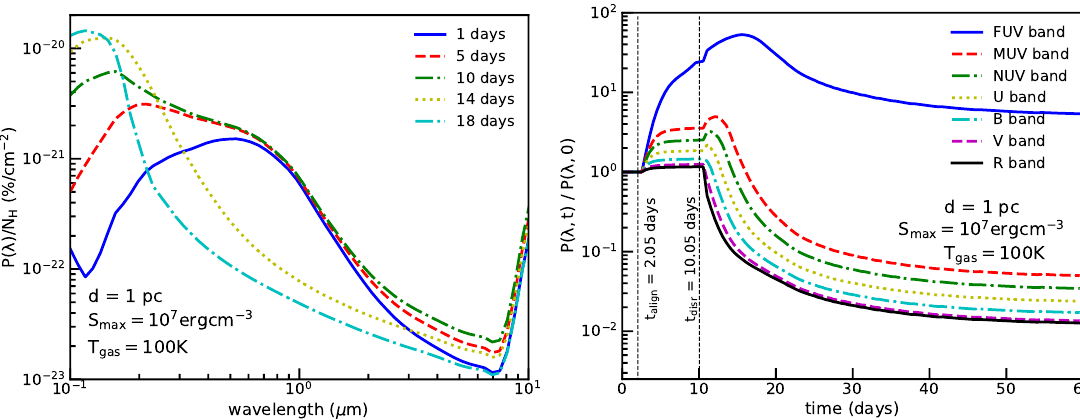
Figure 20. Left panel: Polarization curves evaluated at different times for a dust cloud at 1 pc, assuming S max = 10 7 ergcm − 3 . Enhanced alignment of small grains induces the blueshift of the peak wavelength. The RATD effect reduces polarization at λ > 0.3 µ m, and the efficiency is weaker for higher S max . Polarization curves evaluated at t = 20 days for different cloud distances, assuming S max = 10 7 ergcm − 3 . Right panel: Ratio P ( λ , t ) / P ( λ ,0 ) vs. time from far-UV band (FUV) to V band for different cloud distances assuming S max = 10 7 ergcm − 3 . Optical/NIR polarization degree first increases due to enhanced alignment by RATs and then declines when grain disruption by RATD starts. Dotted vertical lines mark alignment time ( t align ) and disruption time ( t disr ) of silicate grains. From Giang et al.